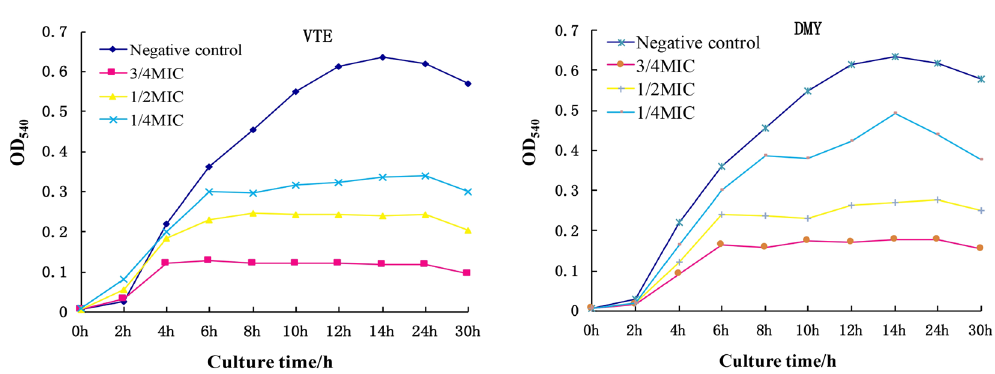
Figure 3. The effect of inhibitors on the growth Curve of S. aureus